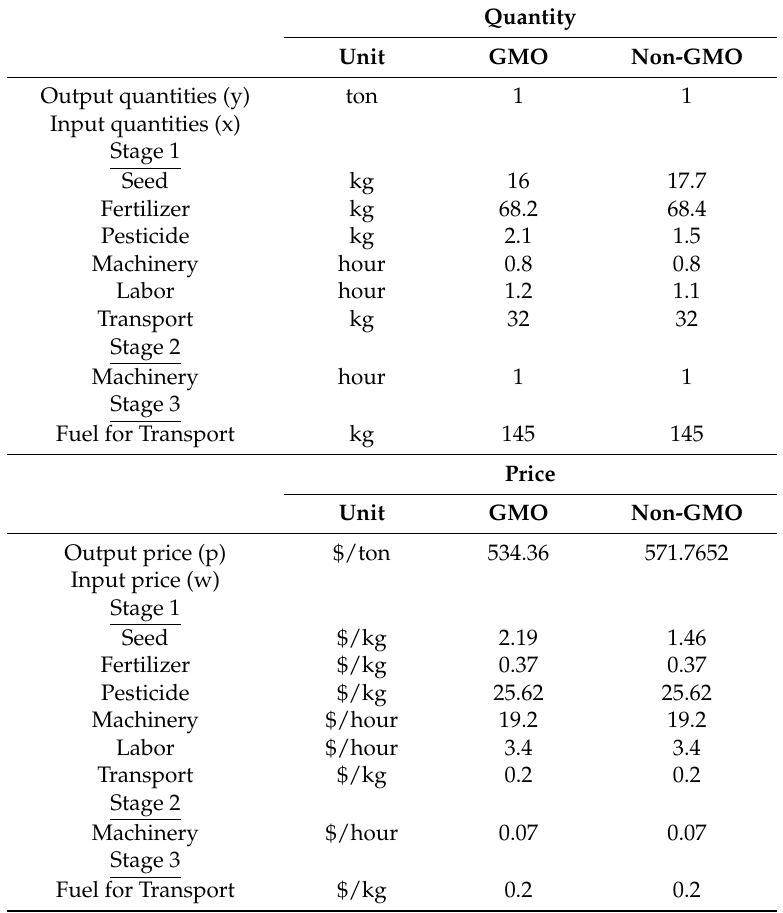
Table 2. Numerical examples of quantities of output (y), input (x), and prices (p and w) of GMO and non-GMO rice production in Indonesia.